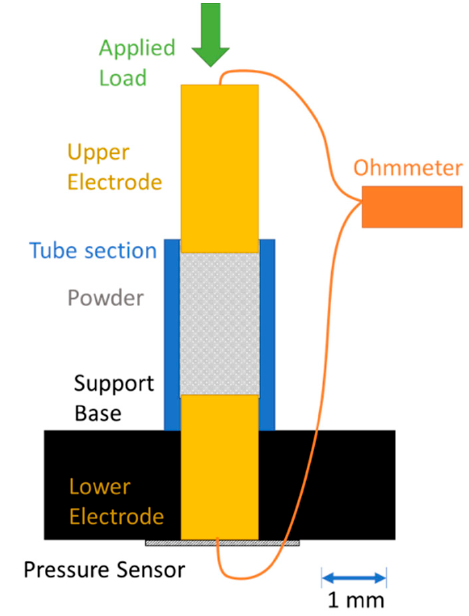
Figure 10. Schematic showing cross section of compressibility test; support base and ohmmeter not to scale.